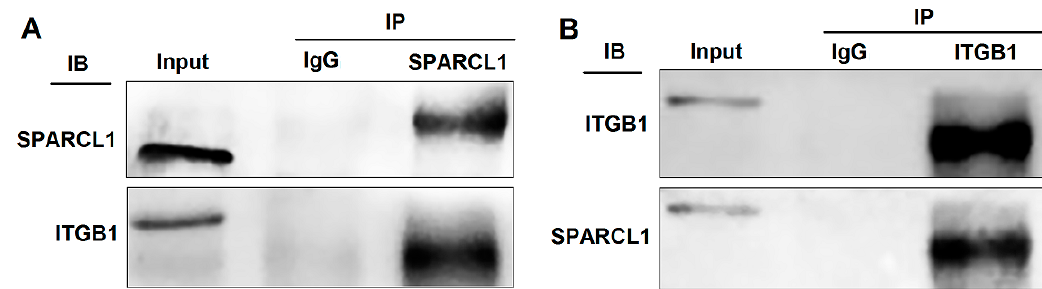
Figure 1. Secreted protein acidic and rich in cysteine like 1 (SPARCL1) interacts with integrin β 1 (ITGB1). ( A ) Co-immunoprecipitation with an anti-SPARCL1 antibody followed by Western blotting with an anti-ITGB1 antibody. ( B ) Co-immunoprecipitation with an anti-ITGB1 antibody followed by Western blotting with an anti-SPARCL1 antibody. Input, IgG, and IP represent the positive control, negative control, and target experimental group, respectively.